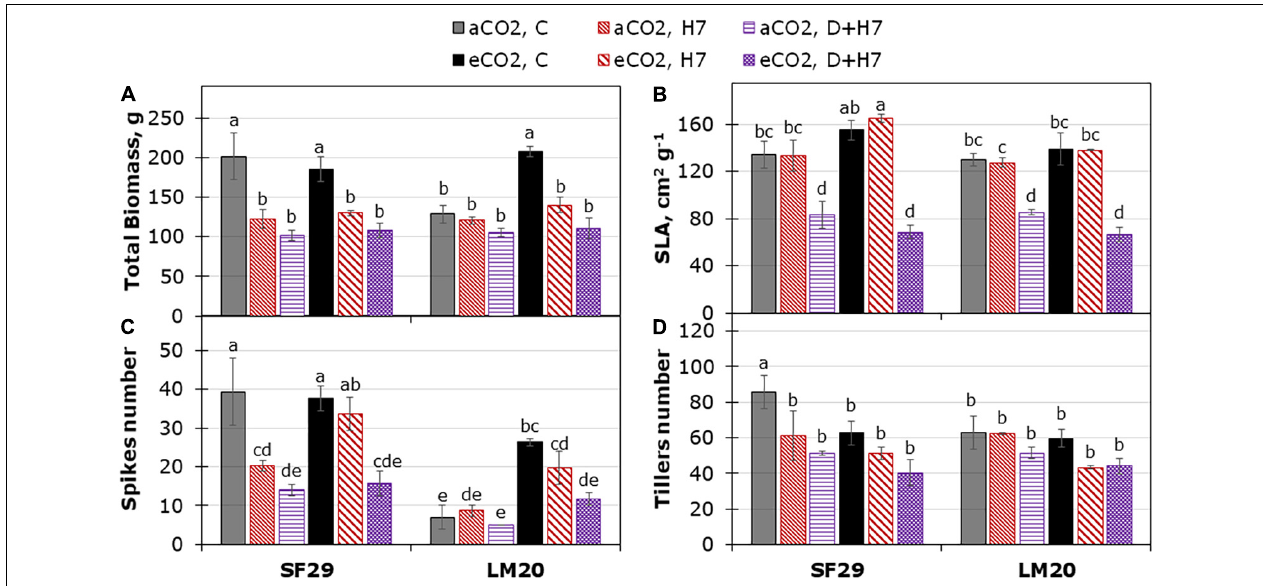
FIGURE 5 | Yield-related traits from destructive harvest during the anthesis stage. (A) Total biomass dry weight, (B) specific leaf area (SLA), and the number of (C) spikes and (D) tillers per plant in heat-sensitive (SF29) and heat-tolerant (LM20) genotypes grown under control conditions (C), heat stress at Day 4 (H4), at Day 7 (H7), and combined heat stress and drought at Day 7 (D + H7) at ambient CO 2 (aCO 2 ) or elevated CO 2 (eCO 2 ). The data represent mean values ± standard error (S.E.) ( n = 3). Different small letters indicate significant differences within variants according to Duncan’s test after ANOVA ( p < 0.05).